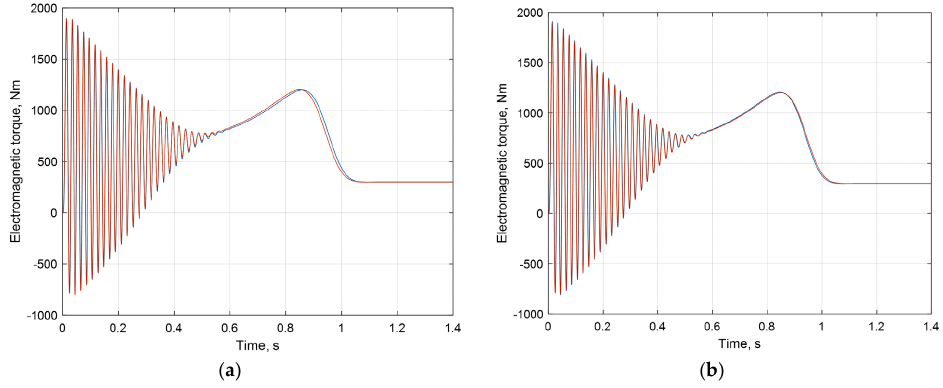
Figure 11. Calculated electromagnetic torque of IM: AVIS method of the 1st order (blue) ( a ), AVIS method of the 2nd order (blue) ( b ), and etalon result